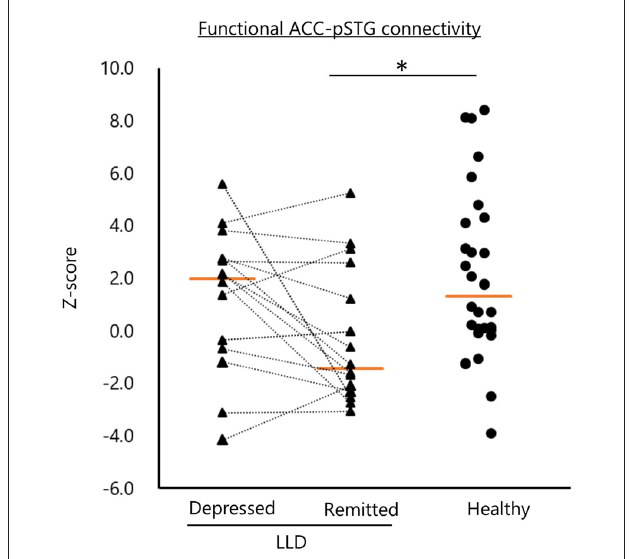
FIGURE 3 | Functional connectivity of the left anterior cingulate and posterior superior temporal gyrus (ACC–pSTG). Patients with remitted LLD ( n = 16) showed lower functional connectivity in the left ACC–pSTG than healthy subjects ( n = 30). Tangerine bars represent the median value of Z-score for each group. ∗ p < 0.05 by Mann-Whitney U test.